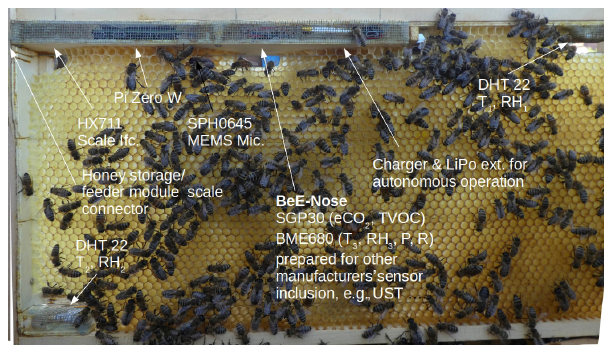
Figure 2. The SmartComb unit related to the reported measure- ments, including BeE-Nose for VILE.